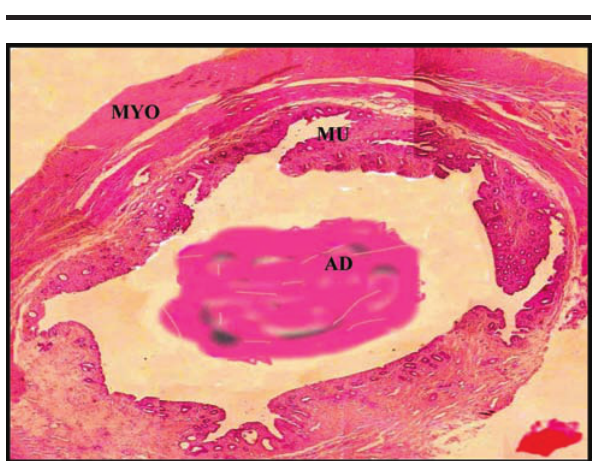
FIGURE 1 – Photography of uterine tube isthmus and the n-butyl-cyanoacrylate plug (arrow) in an animal from 180 observation days